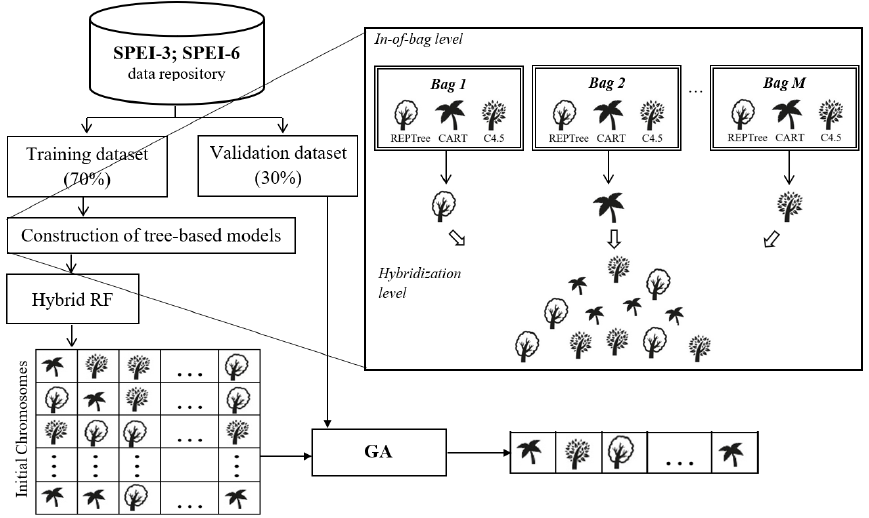
Figure 2. Methodology flowchart for the evolution of hybrid GARF model.